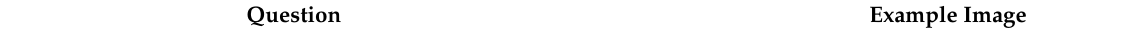
Table 1. Questions used to aid in identification of cyan fluorescence in images. Question Example Image